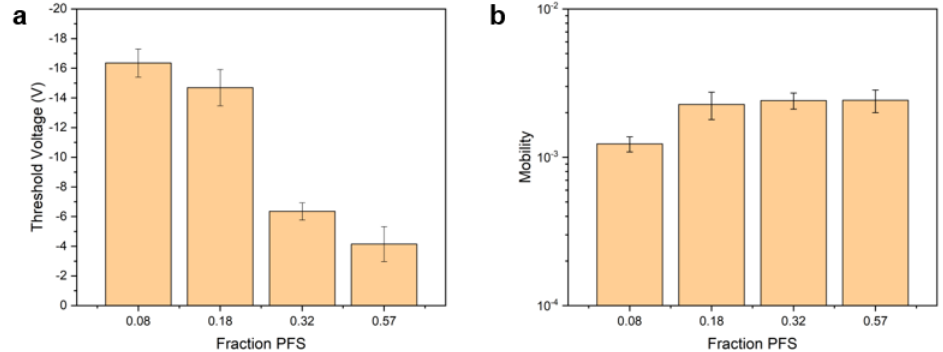
Figure 8. ( a ) Threshold voltage and ( b ) field-e ff ect mobility for CuPc OTFTs with poly(PFS-co-MMA) dielectrics of varying composition.